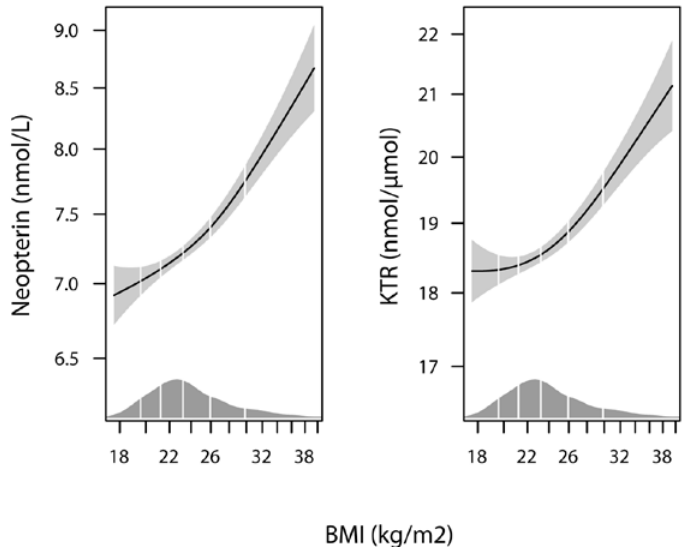
Figure 2. The association of pre-pregnancy BMI with neopterin and KTR by Generalized additive models (GAM), adjusted for use of multisupplements, maternal age, and parity. The solid line shows the fitted model and the shaded areas indicate 95% CIs. KTR, kynurenine/tryptophan ratio.